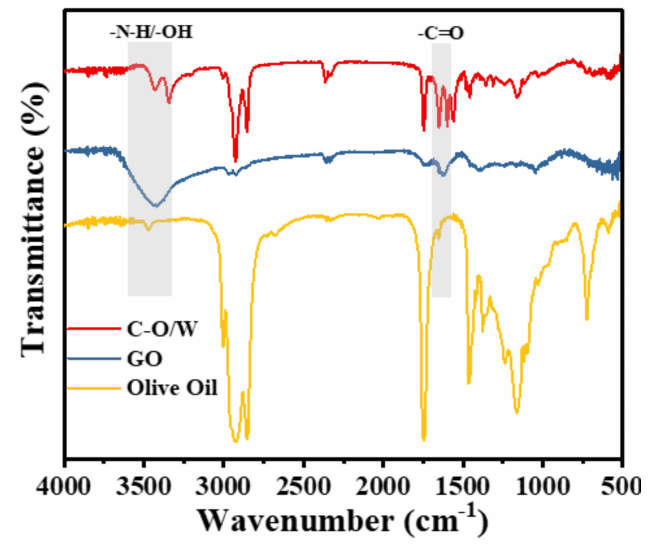
Figure 4. FT-IR spectra of GO, C-O/W microcapsules and olive